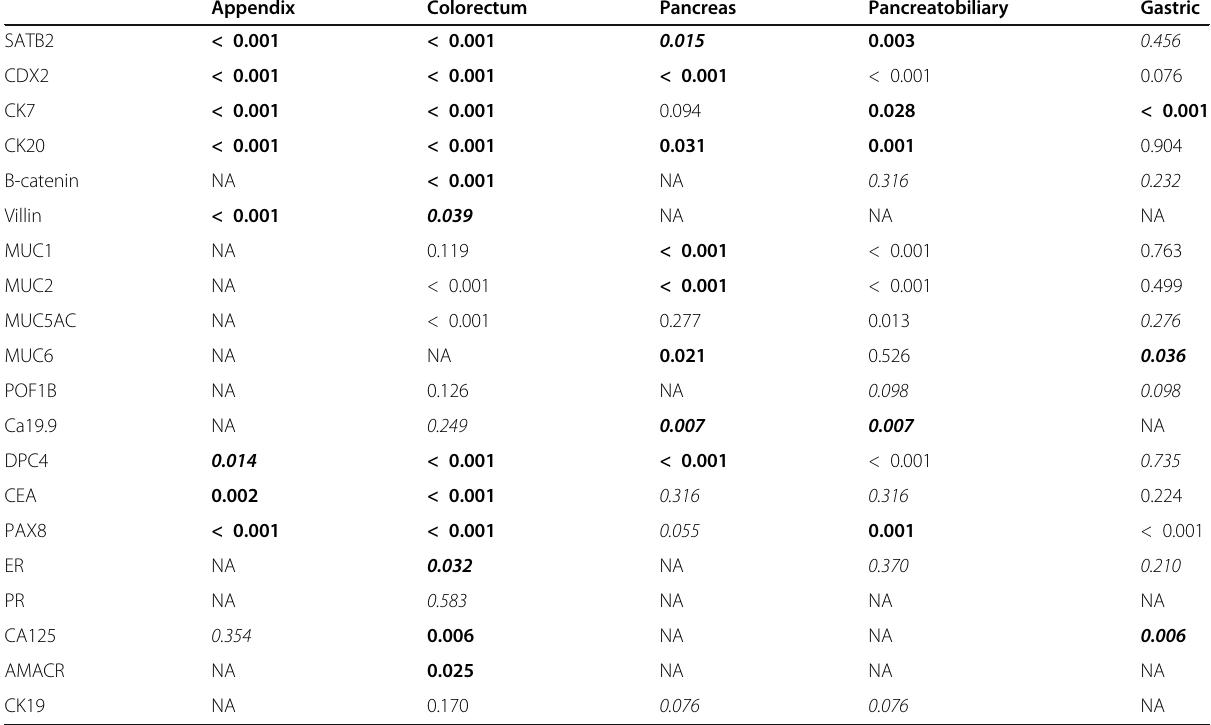
Table 4 Statistical significance of immunohistochemical results between primary mucinous ovarian tumors and metastatic tumors